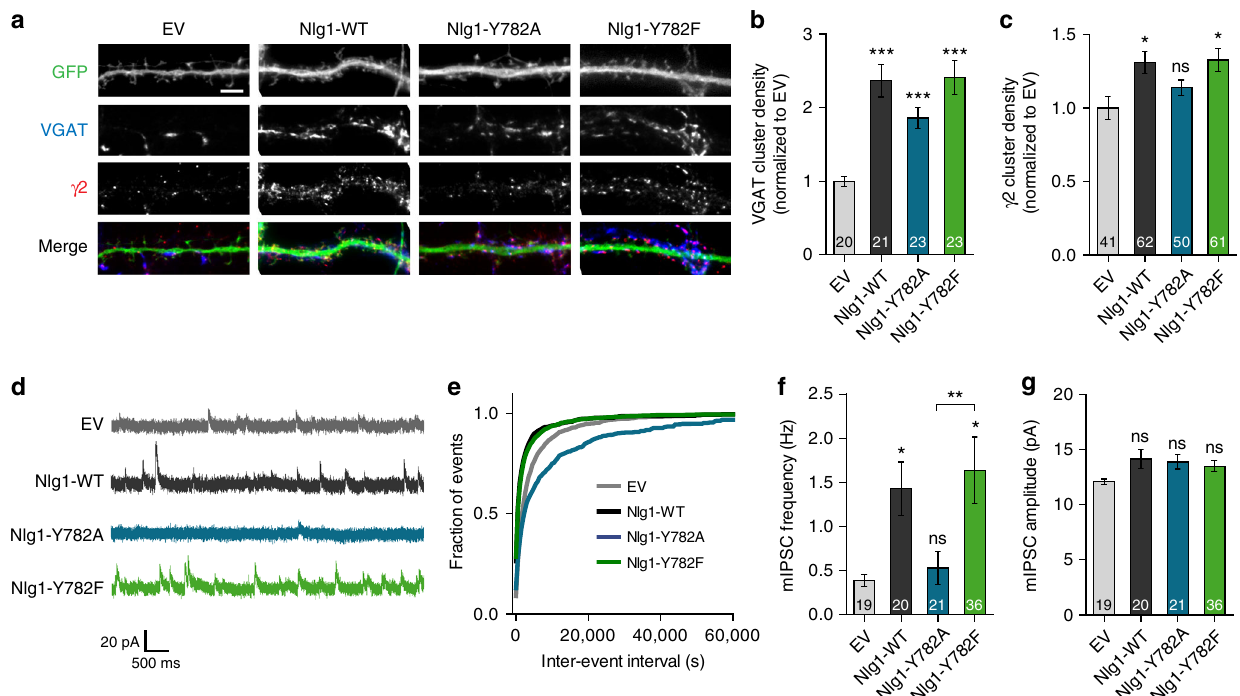
Fig. 7 Expressing Nlg1-Y782F but not Nlg1-Y782A increases the number of functional inhibitory synapses. a Dendrites from DIV 14 – 15 dissociated neurons transfected with EV, Nlg1-WT, -Y782A, or -Y782F along with GFP (green). Neurons were live stained with an antibody against the γ 2 subunit of GABA A receptors (red), then fi xed and counterstained with an antibody against VGAT (blue). Scale bar, 5 µ m. b , c Density of VGAT- or γ 2-positive clusters, respectively, normalized to the EV condition (number of cells indicated within the bars, from 3 independent experiments). d Representative traces of mIPSCs recordings from DIV 14 – 15 neurons expressing EV, Nlg1-WT, -Y782A, or -Y782F clamped at + 10 mV in presence of TTX and NBQX. e Cumulative distributions of the mIPSCs inter-event intervals for the corresponding conditions. f , g Mean mIPSC frequencies and amplitudes, respectively, for each condition (number of cells indicated within the bars, from 4 independent experiments). Data in graphs b , c , f , and g represent mean ± SEM and were compared by a Kruskal – Wallis test followed by Dunn ’ s multiple comparison test (ns: not signi fi cant, * P < 0.05, ** P < 0.01, *** P <